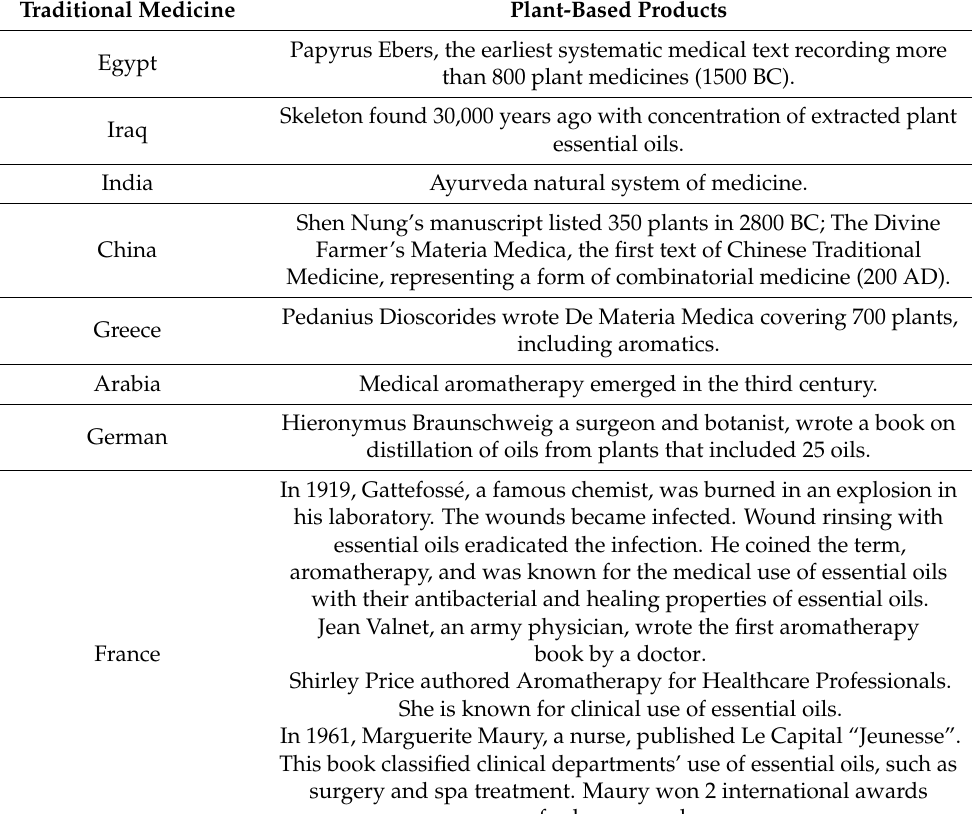
Table 1. Traditional medicinal uses of plant-based products examined throughout the periods up to the 1960’s. The first find is represented by the earliest systematic medical text recording more than 800 plant medicines, Papyrus Ebers, arriving to The Divine Farmer’s Materia Medica, the first text of Chinese Traditional Medicine, representing the first form of combinatorial medicine. The most recent finds include the antiseptic use of essential oils by Gattefoss é and the aromatherapy books by Jean Valnet, Shirley Price and Marguerite Maury. Modified, integrated and reproduced with permission from